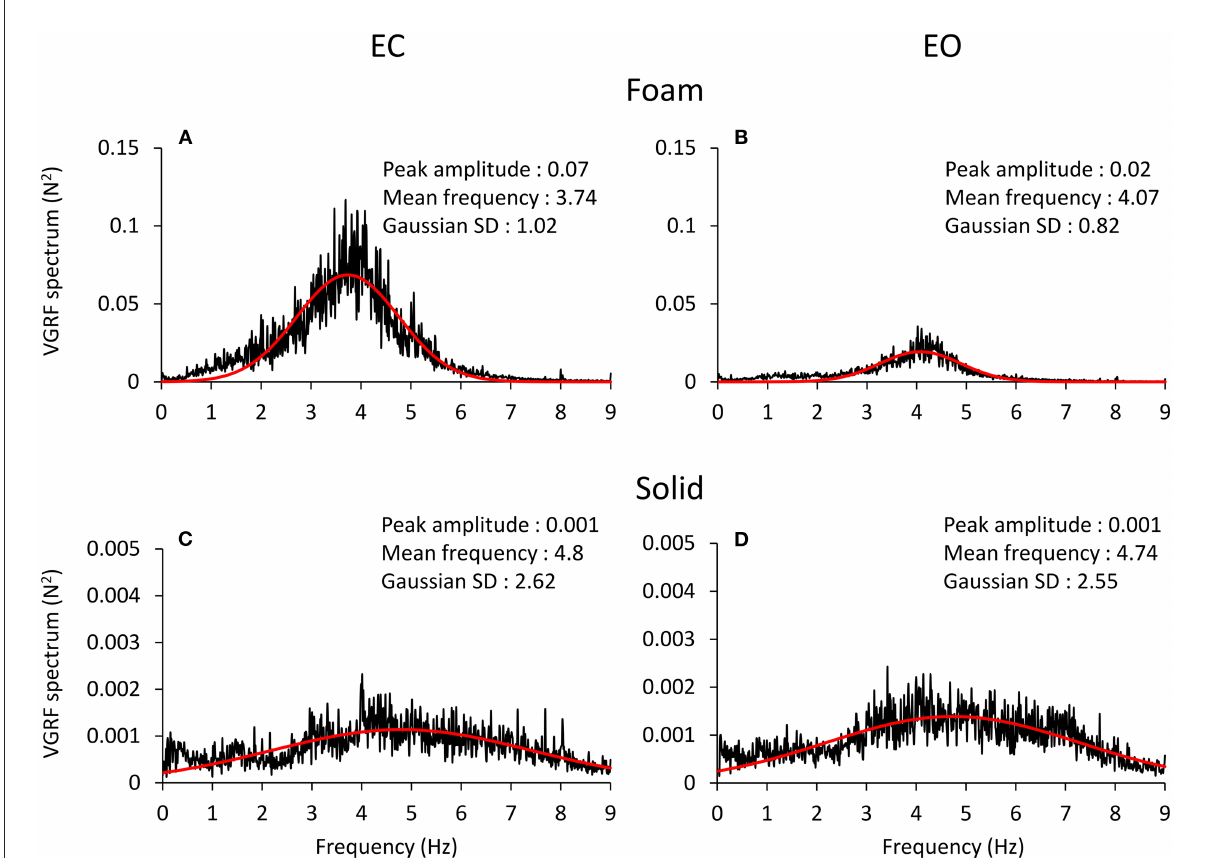
FIGURE3 VGRF frequency spectrum. The mean spectrum profiles across subjects are reported for EC Foam (A) , EO Foam (B) , EC Solid (C) and EO Solid (D) conditions. The VGRF spectrum profile shows a bell curve-like shape, fitted with a Gaussian (red) curve. The parameters of the curve fitting the spectrum are reported in each panel. The VGRF spectrum had a much greater amplitude with Foam than Solid support. Note the extended scale in the ordinates of (C,D) , due to the peak amplitude of the spectrum with Solid support being less than one tenth of that with Foam (A,B) . The VGRF spectrum had a much greater amplitude with Foam than Solid support. The effect of vision was unambiguous with Foam support only. The frequency at the peak of the Gaussian fit was around 4Hz with Foam and around 5Hz with Solid support. The Standard Deviation (SD) of the Gaussian fits were larger for Solid than Foam